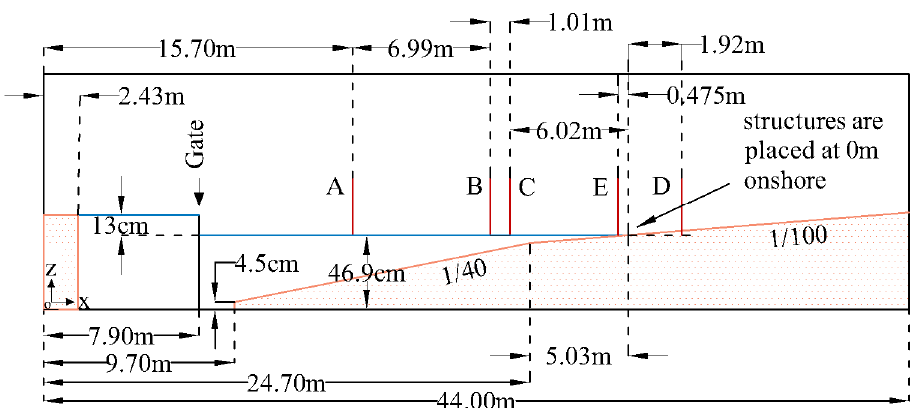
Figure 1. Dimensions and other details of the experimental setup. Similar setup is applied in the numerical simulations which is described in the next section.